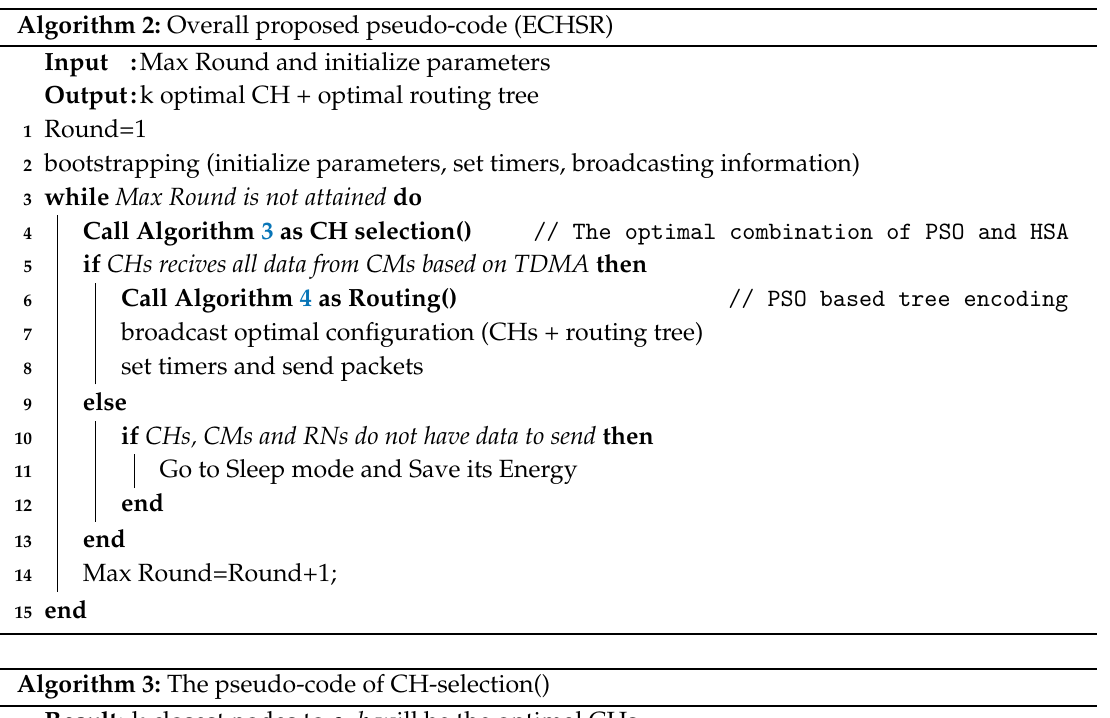
Algorithm 3: The pseudo-code of